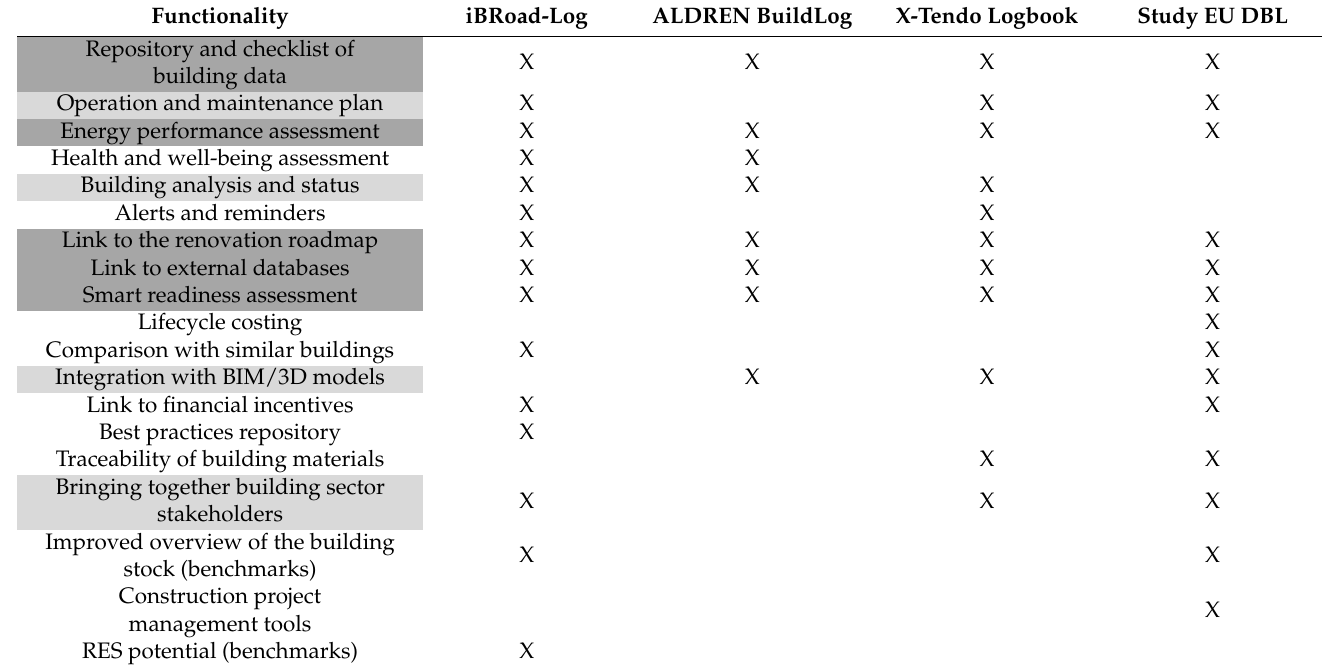
Table 8. Functionalities of the Digital Building Logbook. The functionalities considered by all the DBL initiatives are highlighted dark grey, and those considered by three of them are highlighted light